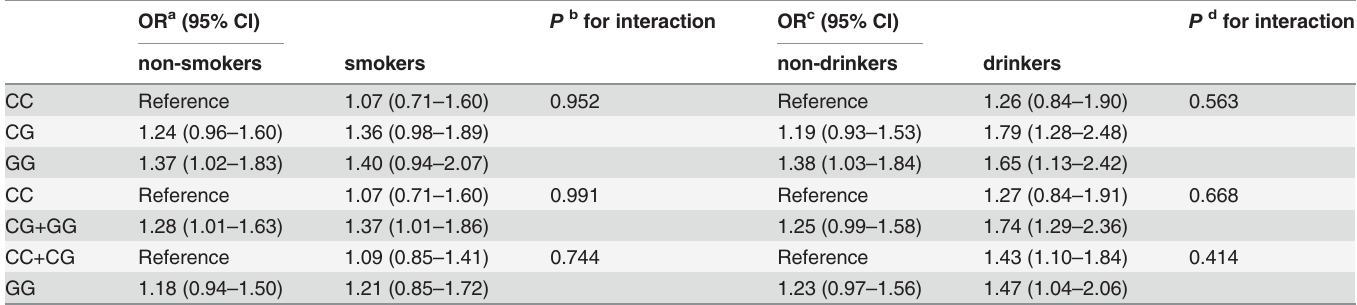
Table 3. Analyses of interaction between ADD1 -rs4963 and environmental exposure. OR a (95%